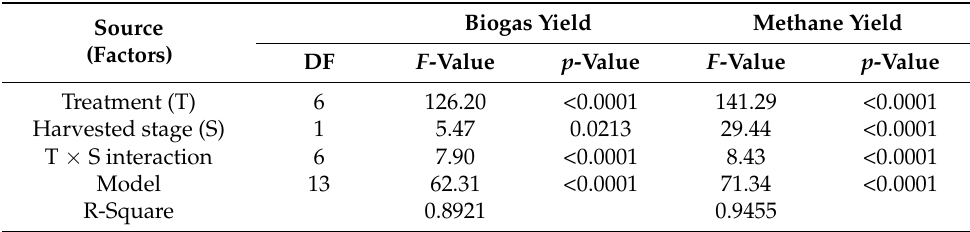
Table 5. Analyses of variance for biogas and methane yield for each experimental factor (treatment and harvested stage) and their interactions. Data included both years ( n = 8).